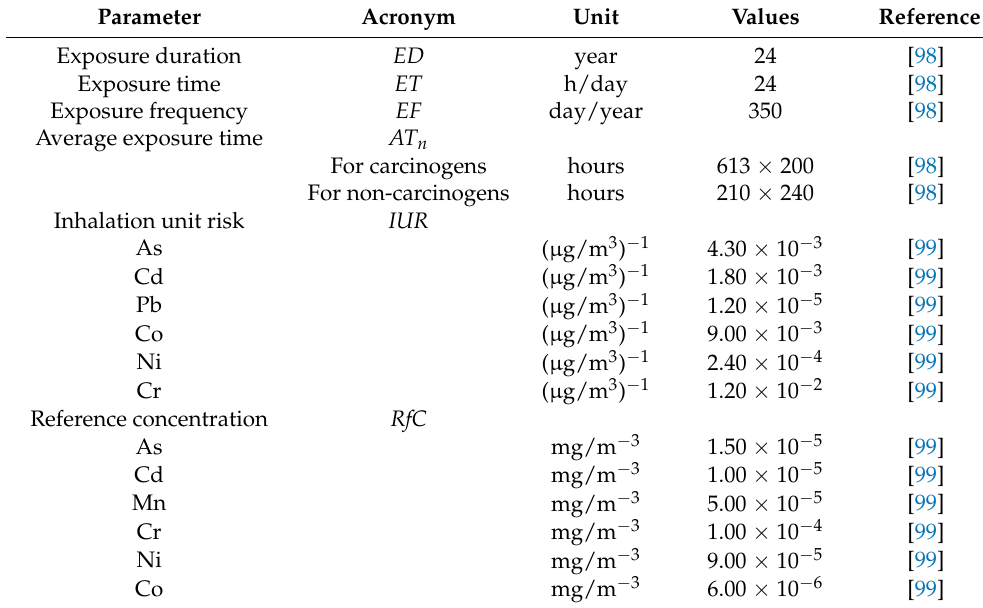
Table 7. Values of parameters used in the health risk